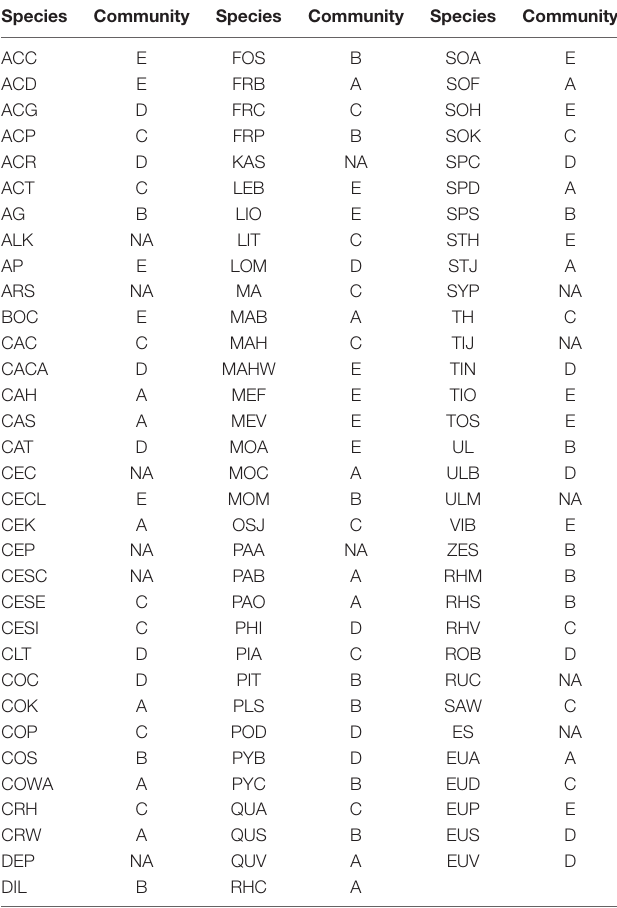
TABLE 2 | Significant associations of woody plant species with five communities ( P ≤ 0.05 level of significance for torus-translation test). Species Community Species Community Species